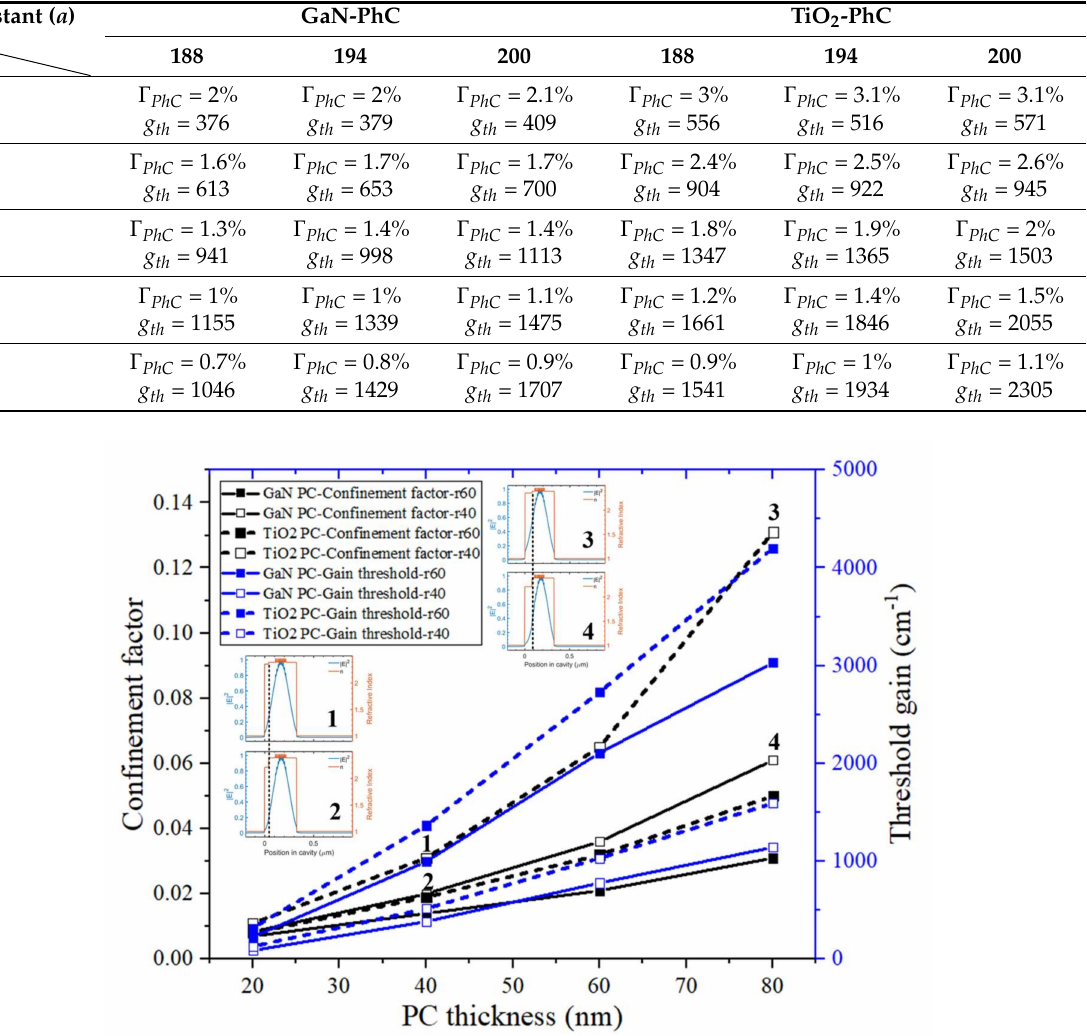
Table 1. Specific list of Γ PhC , g th , at different GaN-PhC and TiO 2 -PhC parameters ( t = 40 nm,